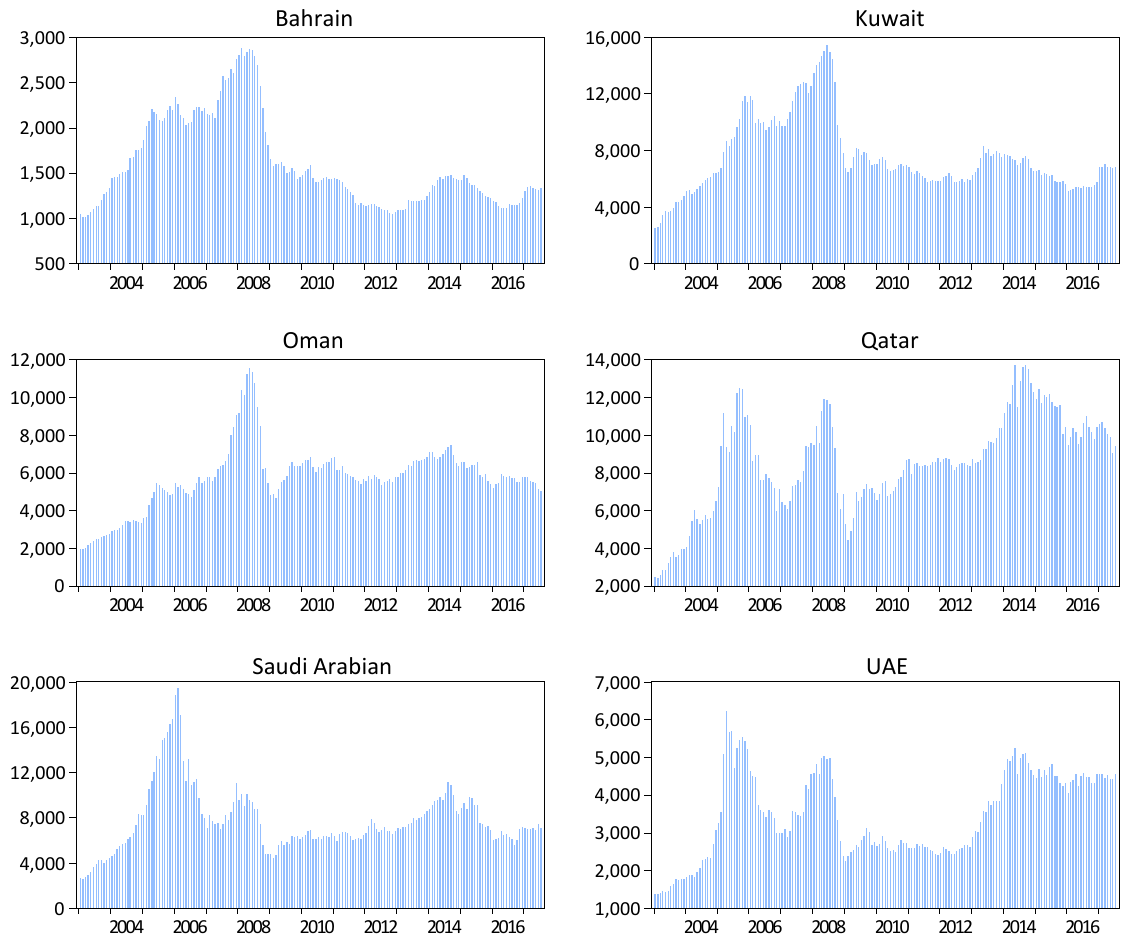
Figure 3. Monthly trend of all 6 stock markets of GCC from 1/1/2003 to 1/7/2017